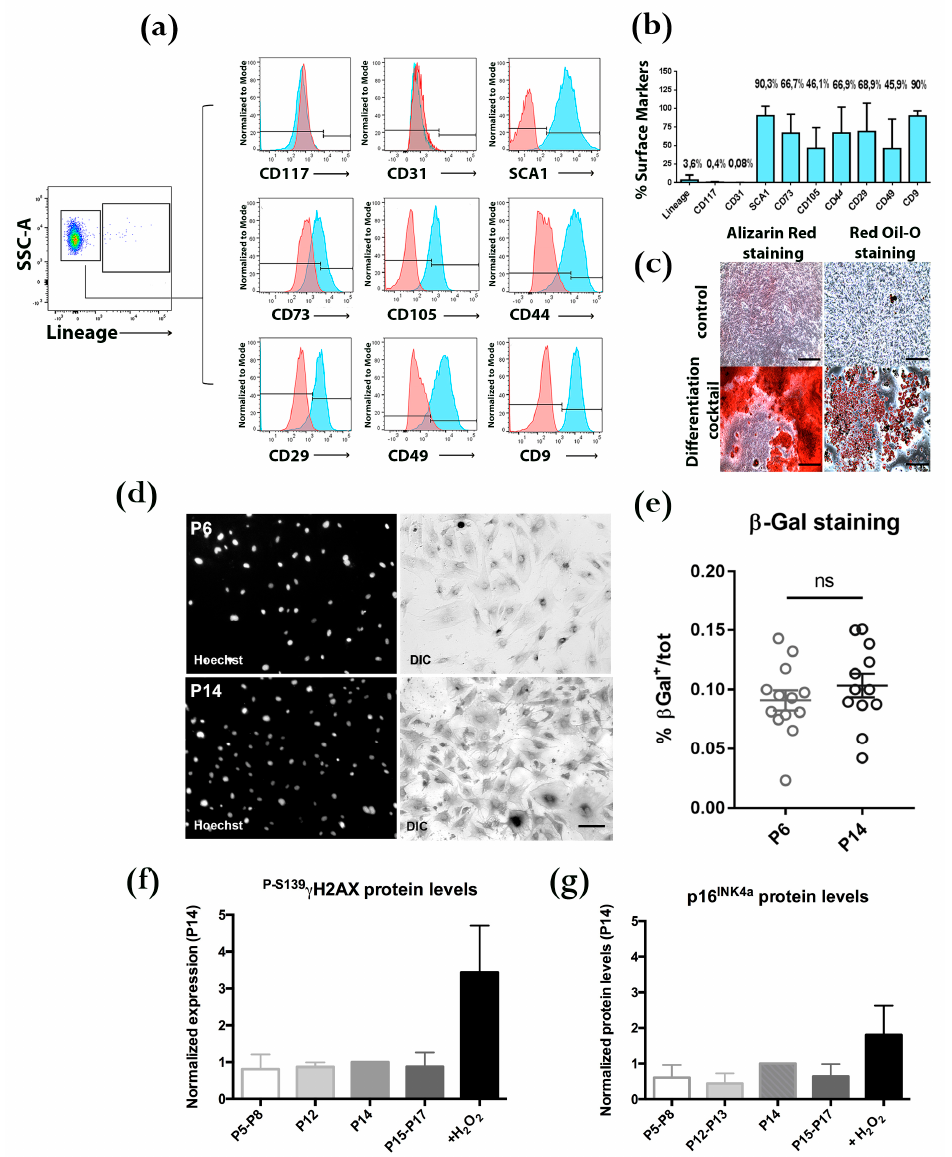
Figure 1. Characterization of murine Bone Marrow Mesenchymal Stem Cells (BM-MSCs). ( a ) Representative panels of flow cytometry analysis showing surface markers of BM-MSCs between passages 6 and 14. Lineage Hematopoietic Markers (LINEAGE) negative cells (96.4 ± 8.4%) are also negative for CD117 and CD31, excluding contamination by hematopoietic cells; they are strongly positive for SCA1 (stemness marker) for CD73 and CD105 (mesenchymal markers) and for CD44, CD29, CD49 and CD9 (markers also found on EVs). ( b ) Percentages of surface marker positive populations (mean ± SEM; flow cytometry experiments of 6 independent BM-MSC cultures). ( c ) Representative images showing di ff erentiation of BM-MSCs into OSTEOCYTES (Alizarin Red staining) and ADIPOCYTES (Oil-red O staining) lineages. Controls: untreated BM-MSC cultures (upper row). Scale bars: 400 µ m. ( d ) β -Gal assay was performed on BM-MSCs at P6 and P14 to test senescence of cells maintained in culture. Cells positive for X-gal were quantified and compared to the total population; no significant di ff erences between the passages were detected ( p = 0.3462; statistical analysis was performed by ANOVA test). Scale bar: 100 µ m. ( e ) Representative images for X-Gal of BM-MSCs at P6 and P14. ( f , g ) Histone H2A.X phospho S139 ( f ) and p16 INK4A ( g ) Western blot analysis, showing that senescence processes are not di ff erently activated during cell passages in